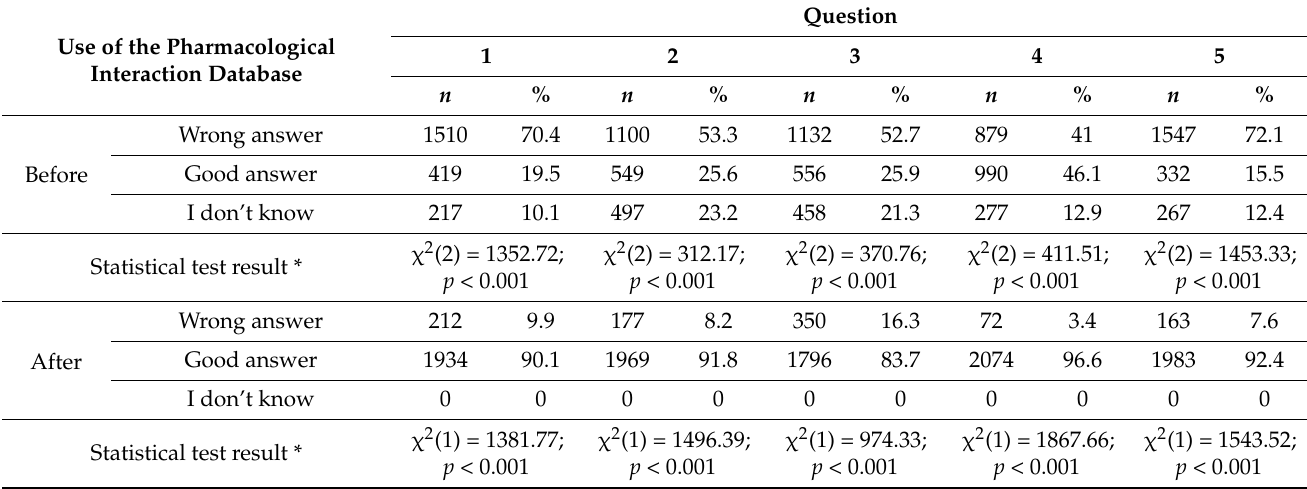
Table 3. The studied group of psychiatrists providing a correct or incorrect answer to the questions asked or stating that they do not know the answers.